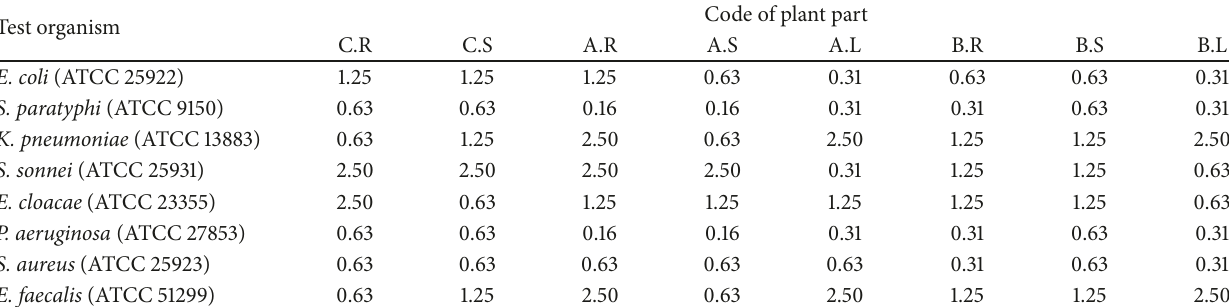
Table 2: Minimum Inhibitory Concentration (mg/ml) of plant